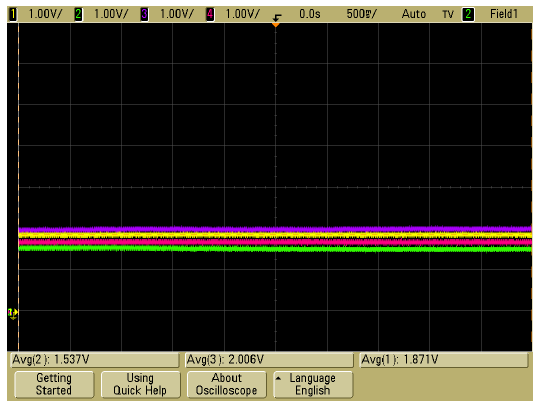
Figure 17. Response to the connection of the power